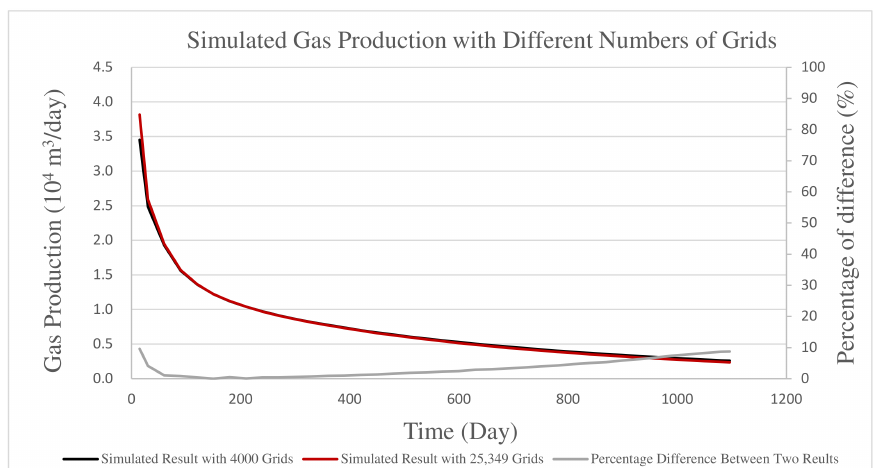
Figure 5. Comparison of gas productions simulated by using different grid sizes and grid